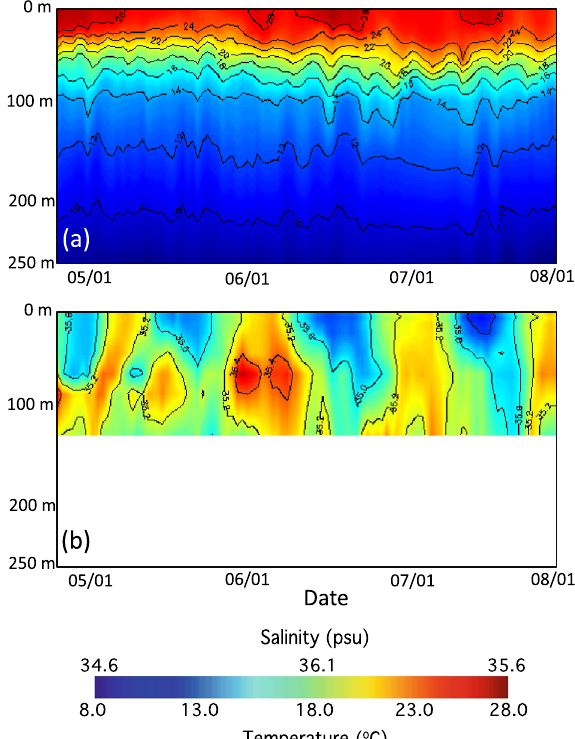
Figure 6. Profiles in the upper 250 m at the TAO_140W station from April 25–August 3, 2020 for ( a ) temperature and ( b ) salinity. Note that there were no measurements of salinity below 120 m depth at the TAO_140W